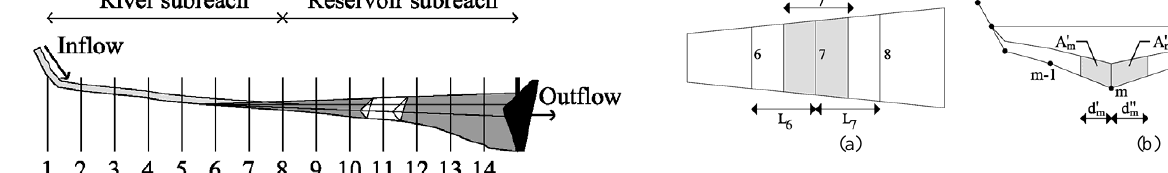
Fig. 2. Spatial discretisation of a reservoir along the longitudinal Figure 2: Spatial discretisation of a reservoir along the longitudinal profile showing the river profile showing the river sub-reaches at cross-sections 1–7 and the sub-reaches at cross-sections 1-7 and the main reservoir body at cross-sections 8-14. For main reservoir body at cross-sections 8–14. For each-cross-section, each-cross-section, sediment deposition and re-entrainment is calculated for a control volume sediment deposition and re-entrainment is calculated for a control volume (as shown exemplarily for cross-section 11). (as shown exemplarily for cross-section 11)